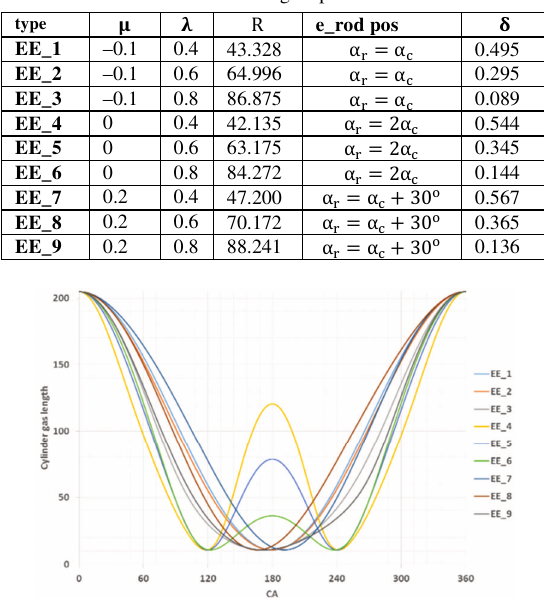
Fig. 8. STDE piston motion curves Table 3. Geometrical engine parameters for EE